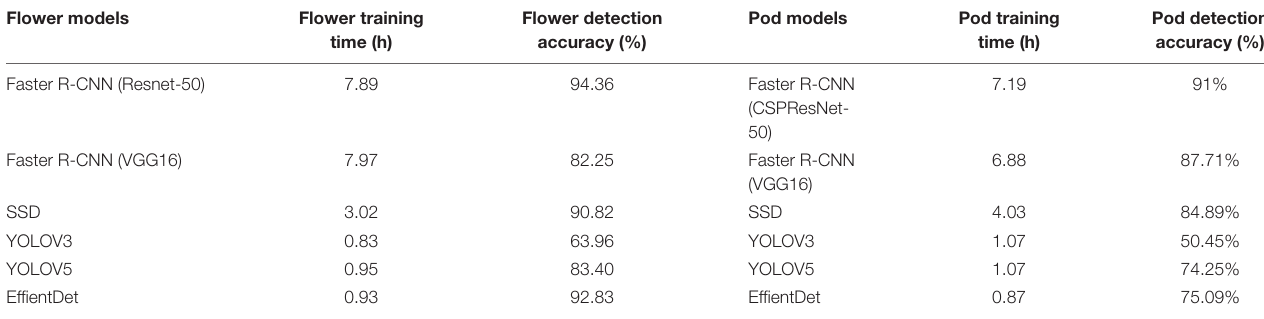
TABLE 4 | Comparison of different object detection algorithms of flowers and pods. Flower models Flower training